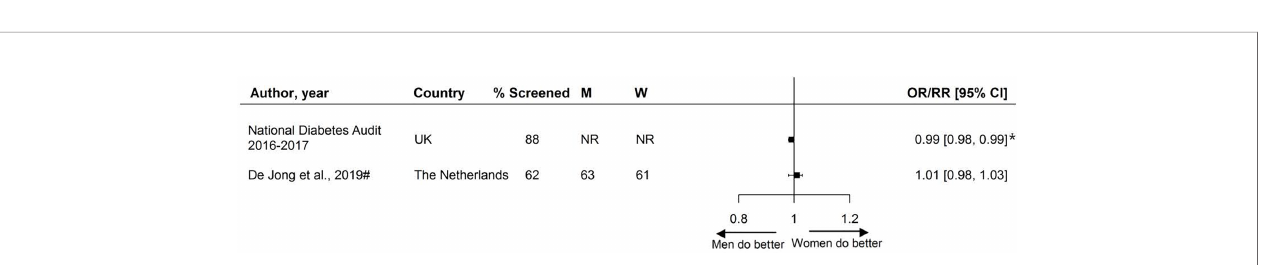
FIGURE 5 | Assessment of BMI, expressed as adjusted odds ratios (OR) or relative risks (RR) with corresponding 95% con fi dence intervals (CI). W = % of screened women; M = % of screened men; UK, United Kingdom; # = Relative risk. Men = reference. * = statistically signi fi